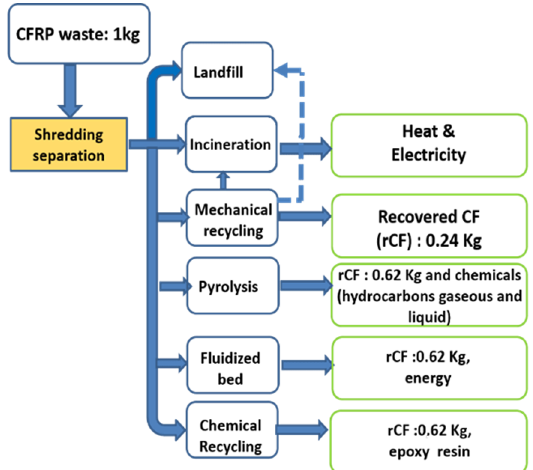
Figure 4. Structure of waste management routes referring to CFRP 1 kg as FU [1,5] . Recycled carbon fiber recovery data was mined from the literature; mechanical recycling [2] , pyrolysis [19] , fluidized bed [20] , chemical recycling [5] .